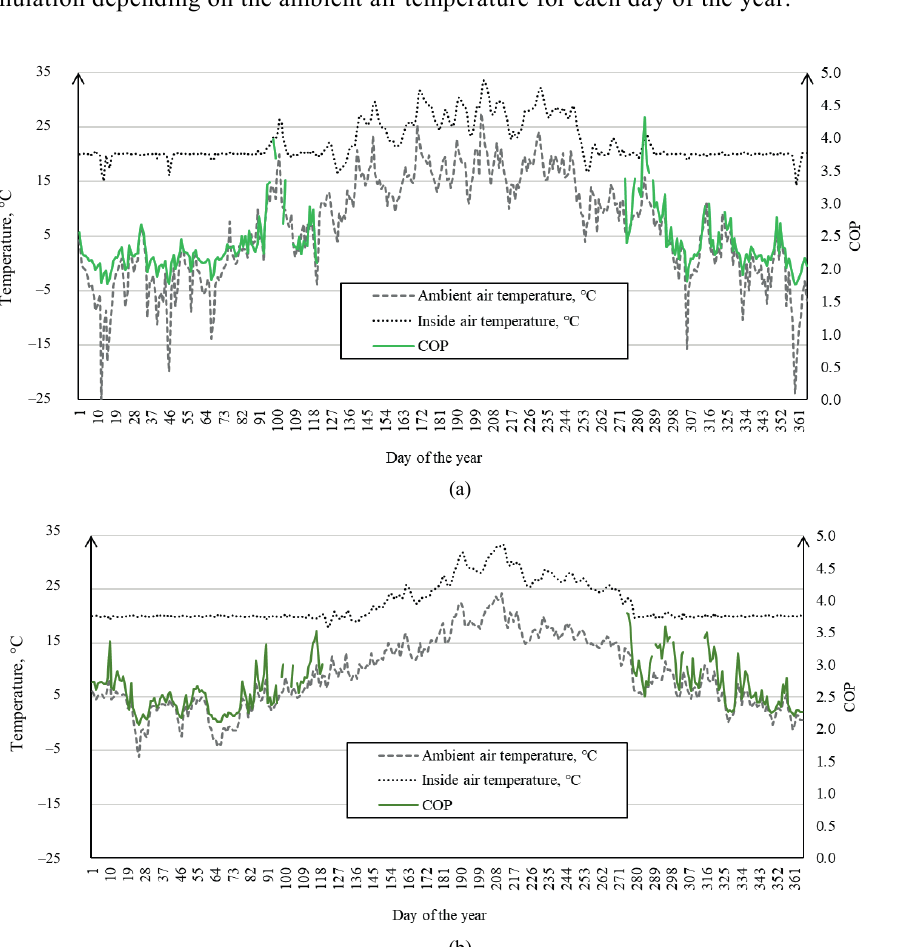
Fig. 5. COP dependence on ambient air temperature in: a) Vilnius and b)